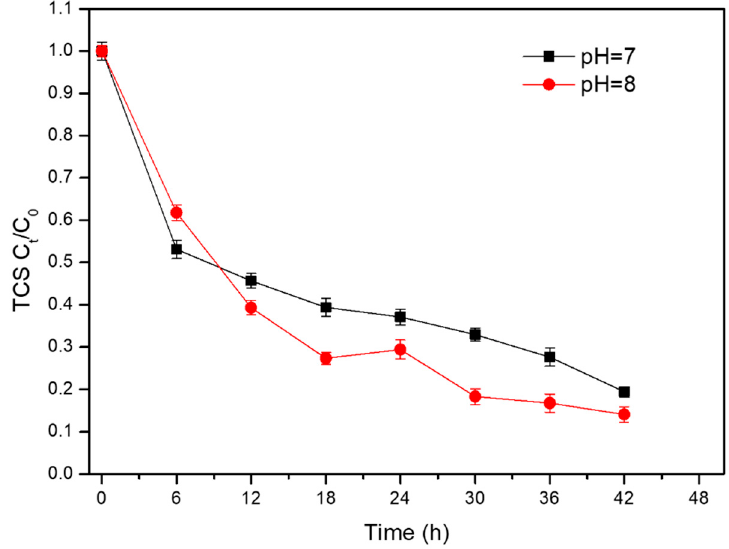
Figure 4. The adsorption of TCS in abiotic MFC at two different pH.